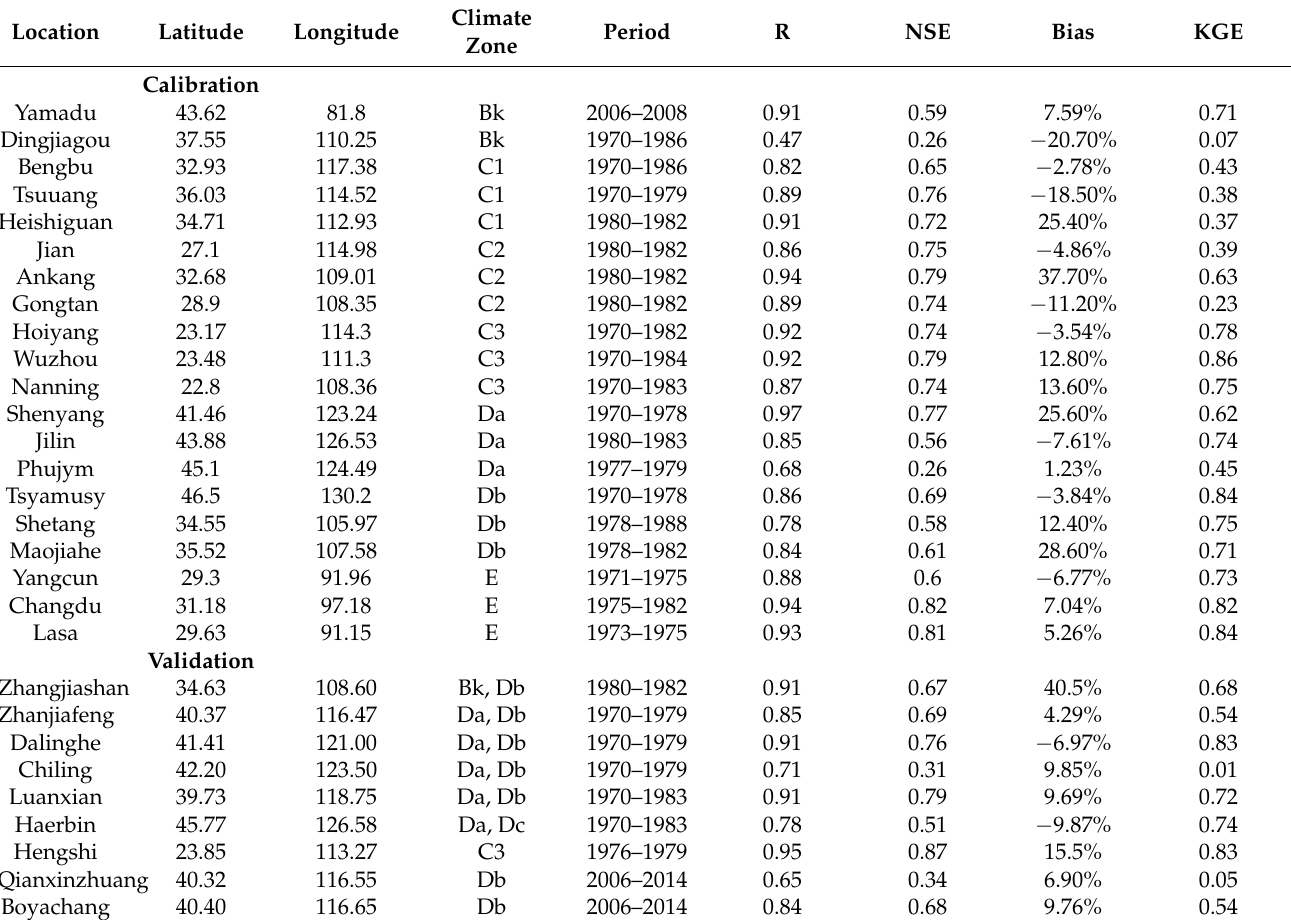
Table 3. Station information and statistics of calibrated and validated monthly